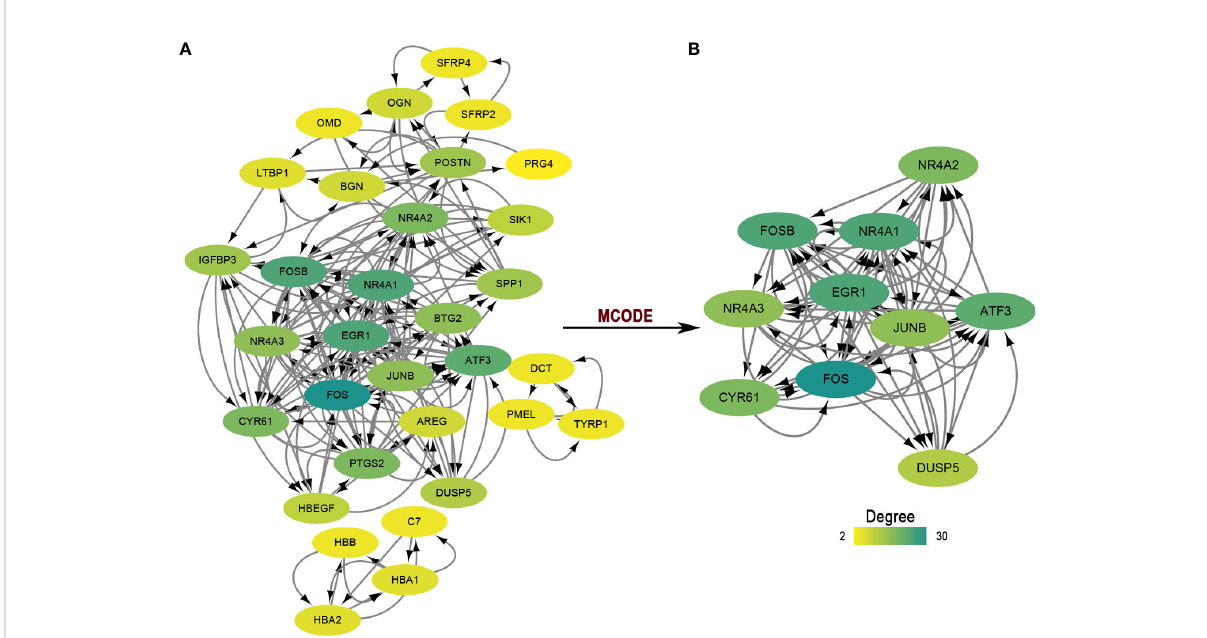
FIGURE 2 The PPI network and module analysis. (A) The entire PPI network of DEGs. Total of 32 nodes and 188 interacted edges in the PPI network. (B) A signi fi cant module of the PPI network. PPI, protein-protein interaction.